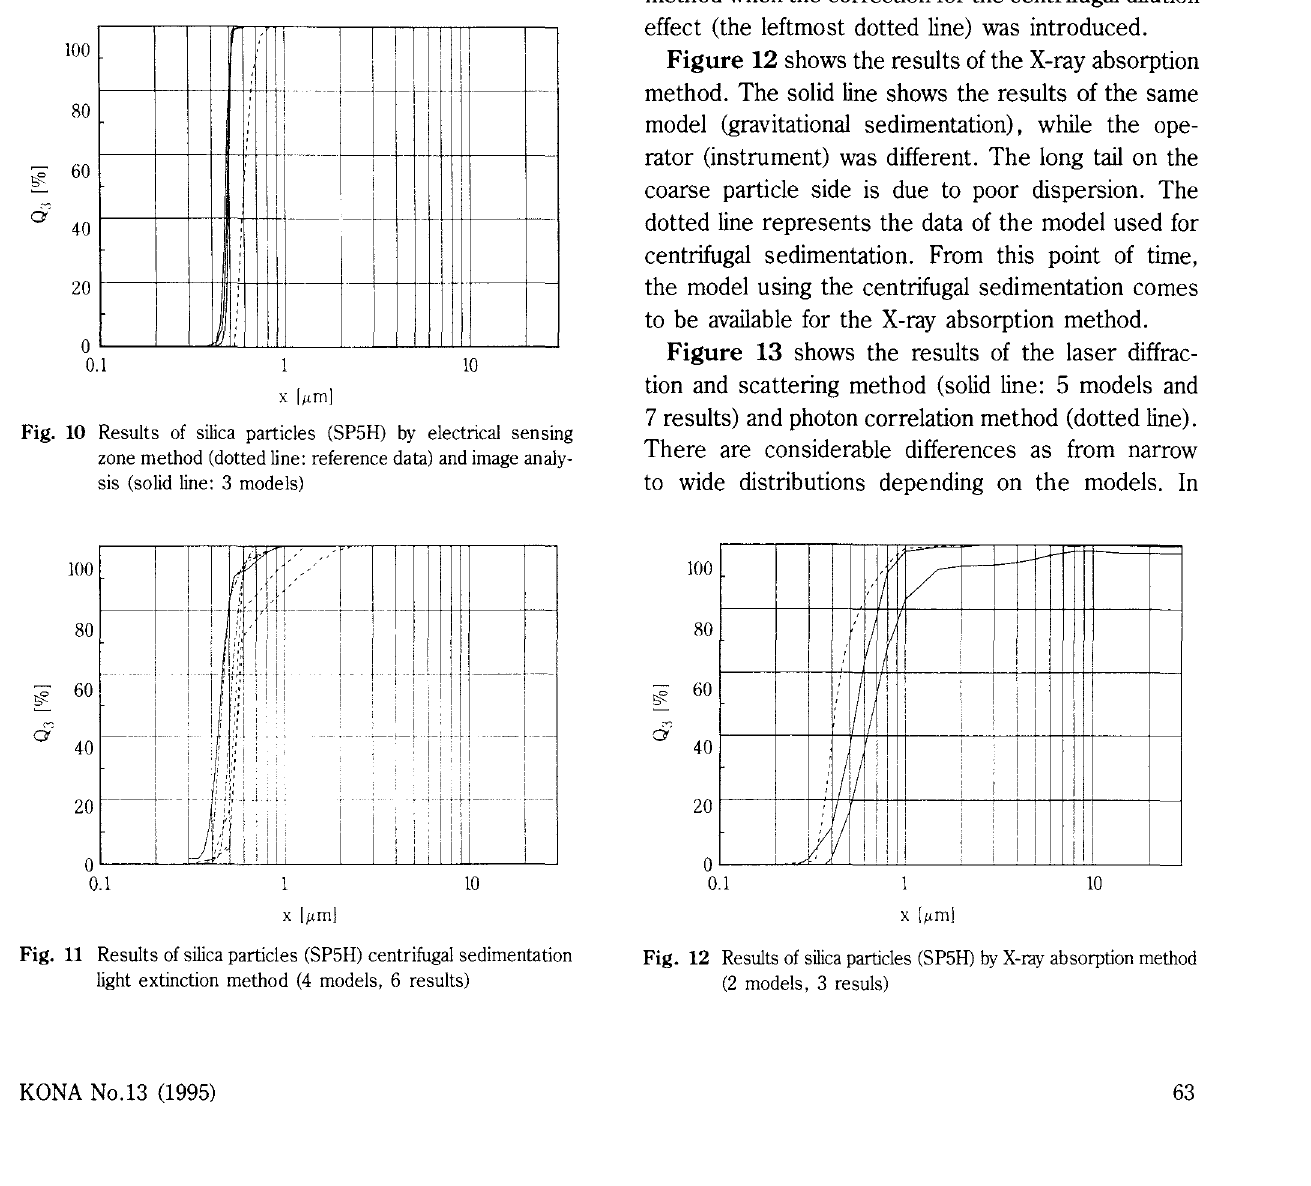
Fig. 11 Results of silica particles (SP5H) centrifugal sedimentation light extinction method (4 models, 6 results)